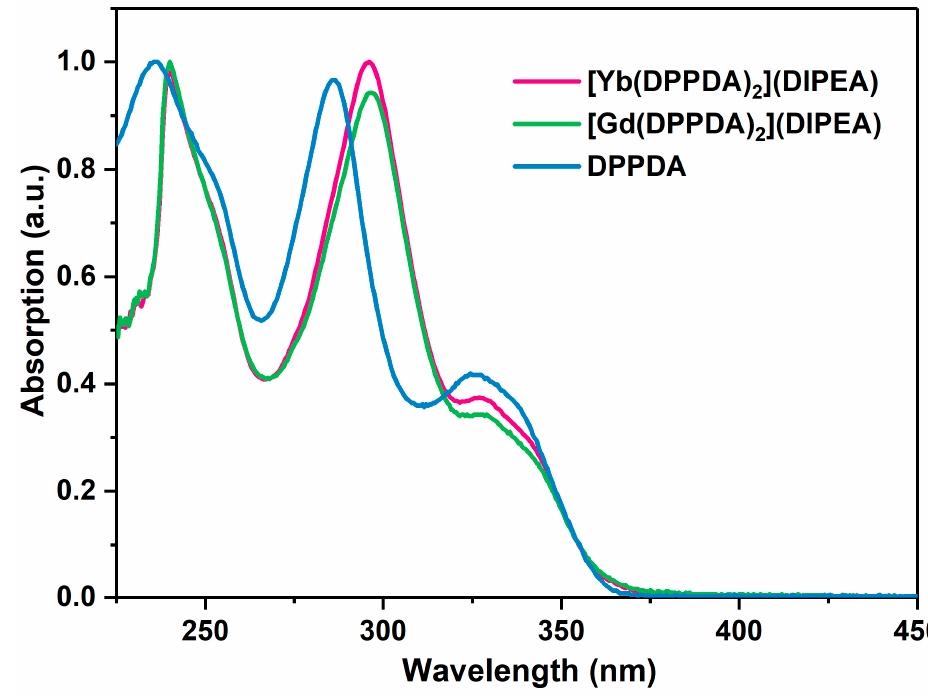
Figure 2. UV-Vis absorption spectra of DPPDA (in 1 × 10 − 5 mol/L CH 2 Cl 2 solution) and [Ln(DPPDA) 2 ](DIPEA) (in 1 × 10 − 5 mol/L CHCl 3 solution) at room temperature.